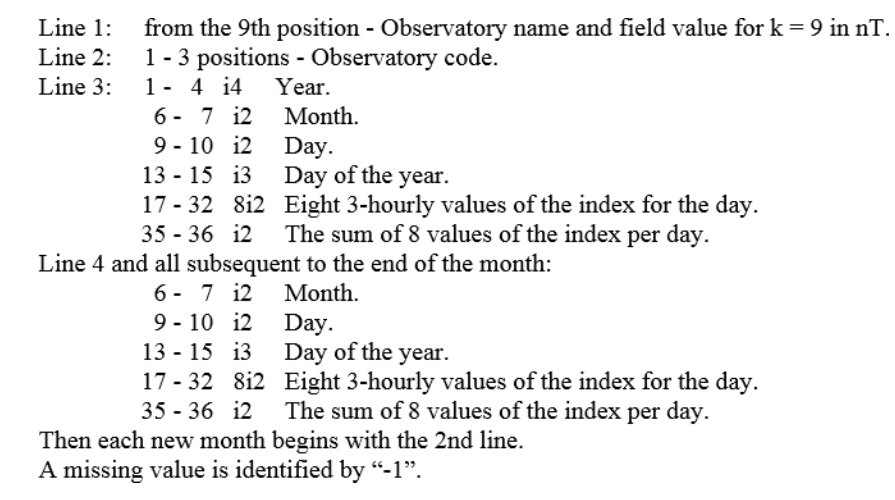
Figure 7. Format description for K index data (http://www.wdcb.ru/stp/geomag/format_K_index.html, last access: 1 September